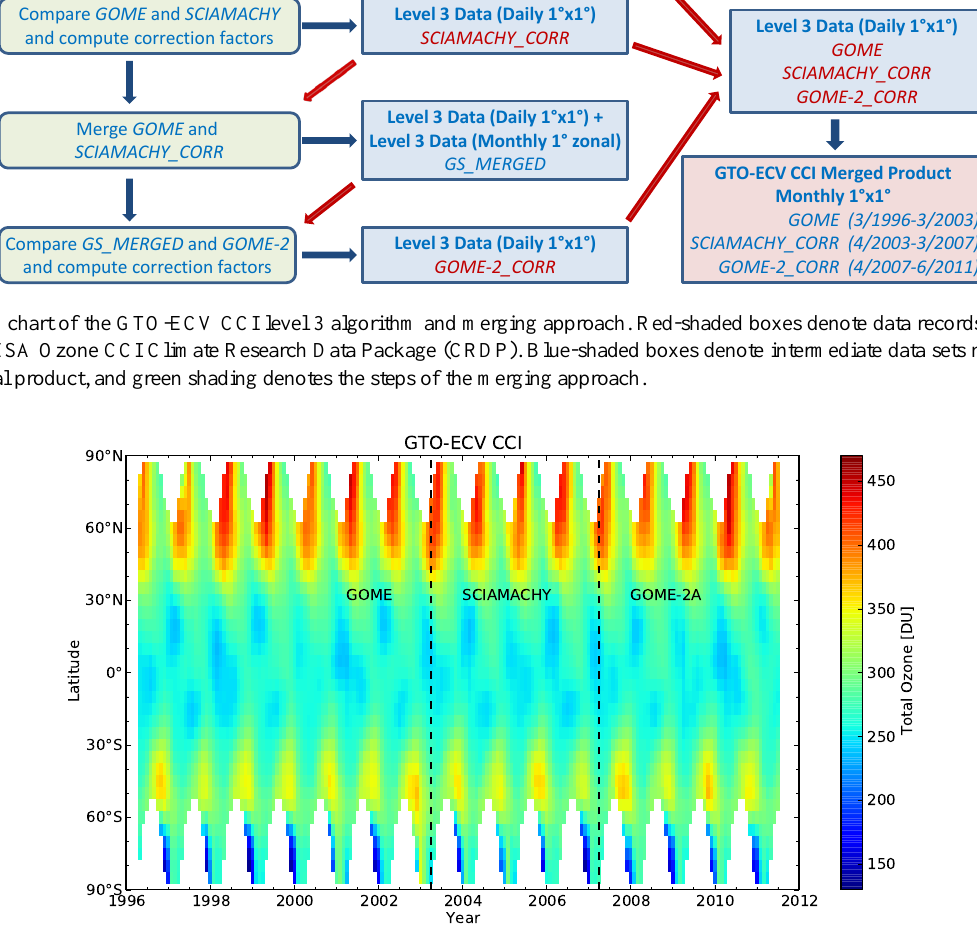
the merged final product and green shading denotes the three steps of the merging